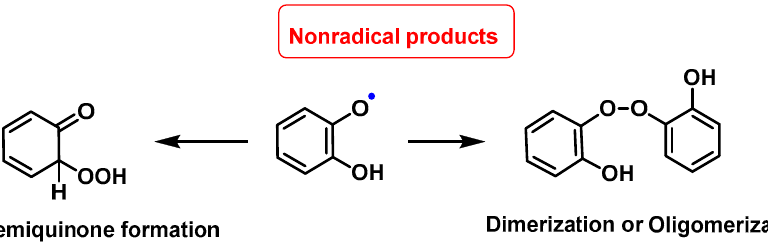
Figure 60. PhO • forms non-radical products by dimerization, oligomerisation or formation of semiquinone.